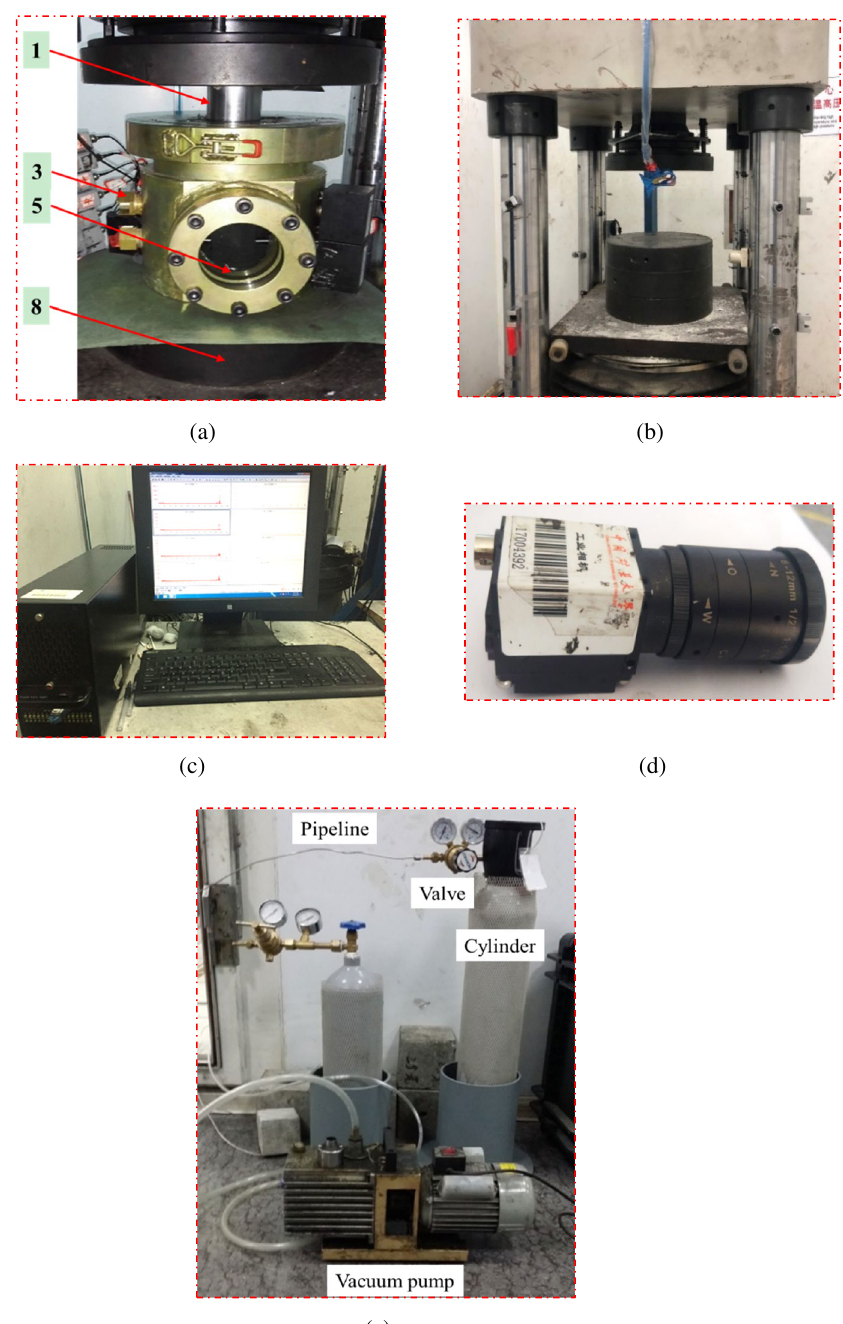
Figure 2. Physical object images of key parts of the experimental system. ( a ) Visible sealed cylinder. ( b ) Electro-hydraulic servo loading platform. ( c ) AE acquisition device. ( d ) High-speed camera. ( e ) Gas charging and discharging